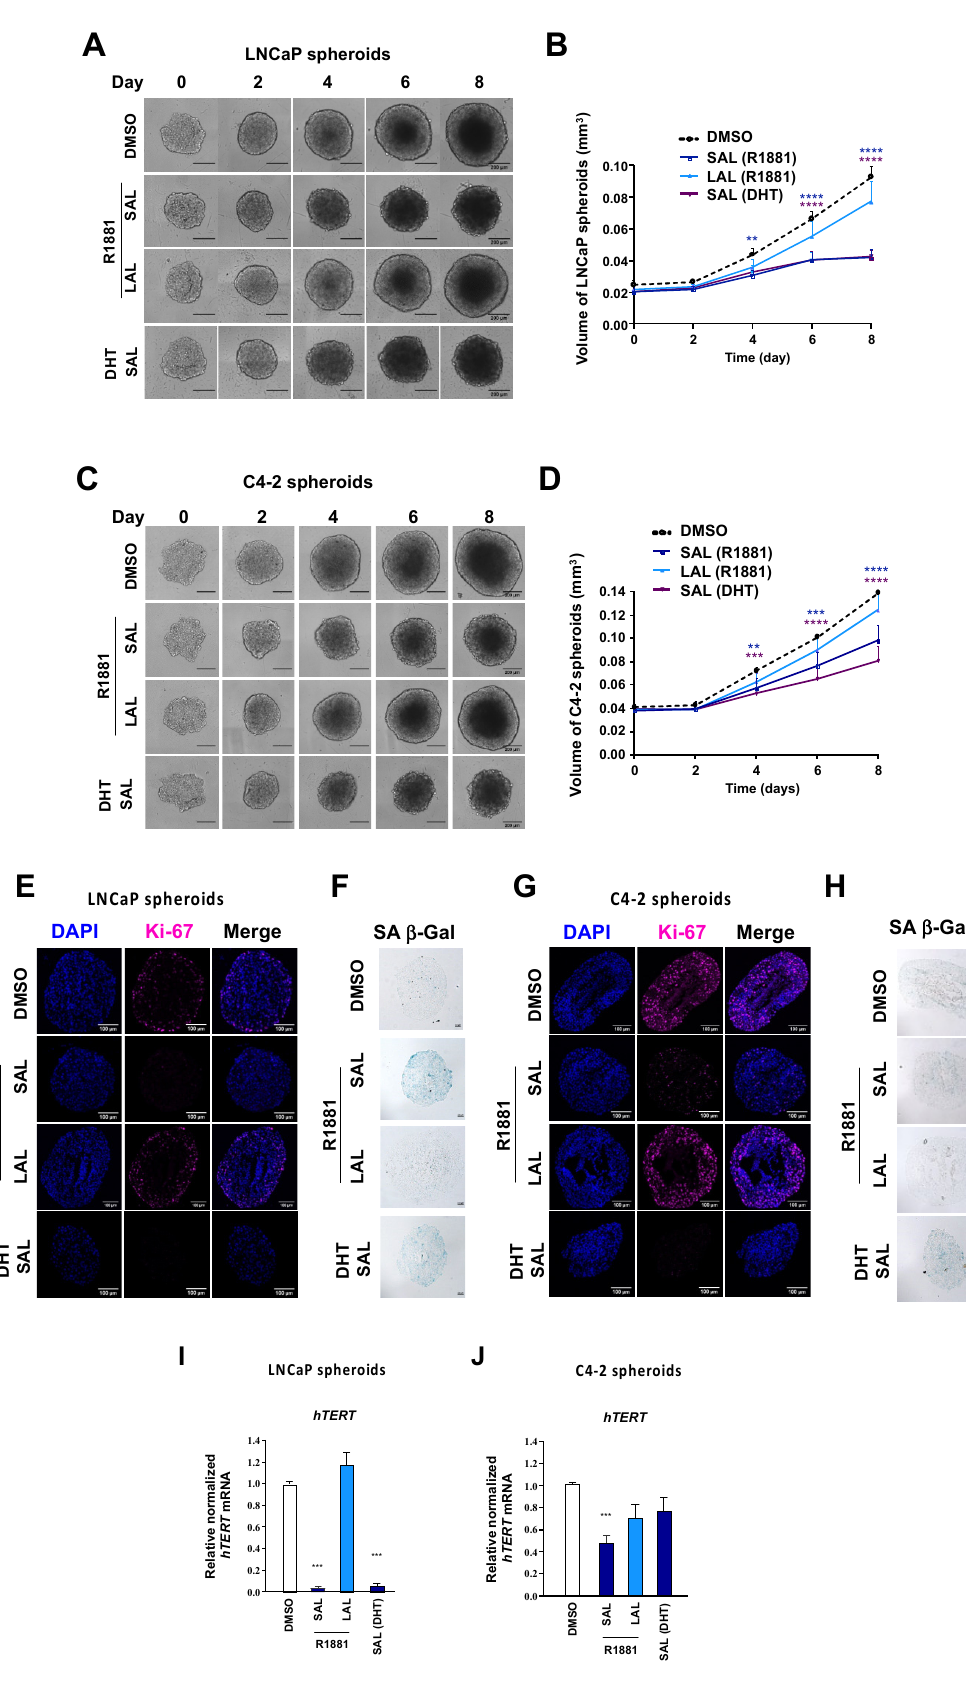
Figure 2. Inhibition of LNCaP or C4-2 spheroid growth and hTERT expression by SAL treatment. Spheroids from